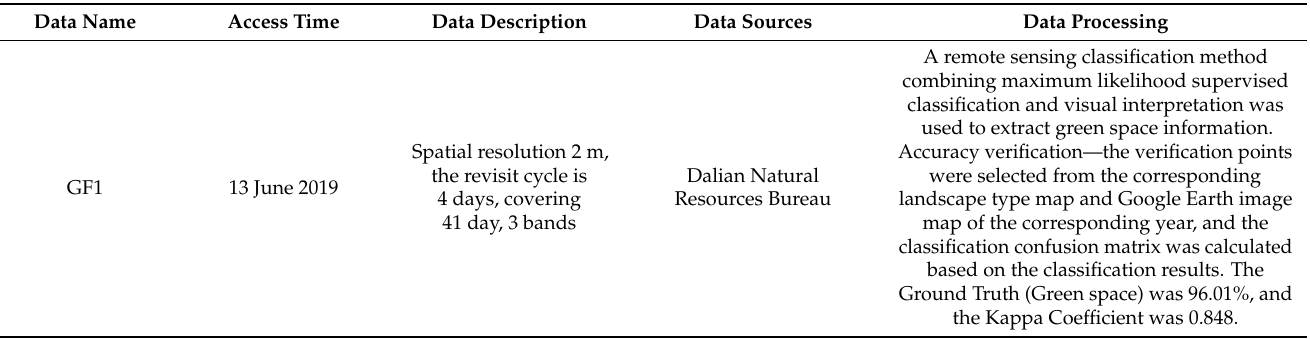
Table 1. Data source and